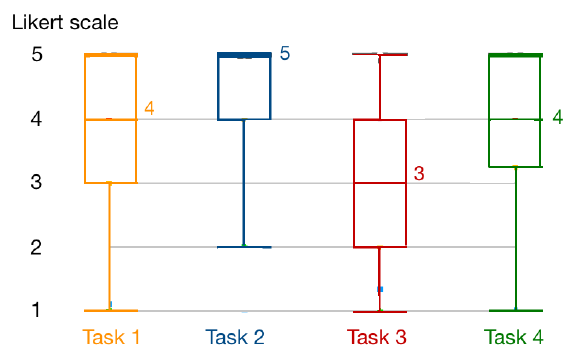
Figure 21: Boxplots of how realistic participants rated tasks accord- ing to a 5-point Likert Scale, 1 being not realistic at all and 5 being very